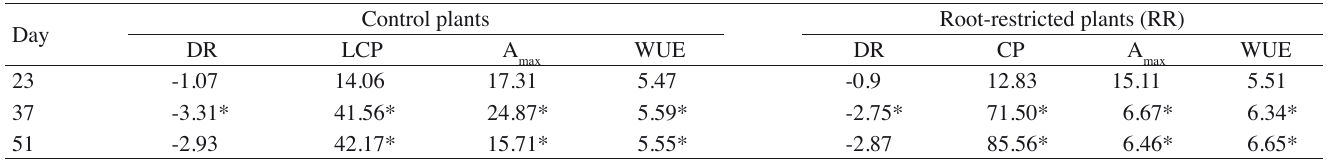
m -2 s -1 ), light compensation point (LCP, µmol m -2 s -1 PAR), maximum CO 2